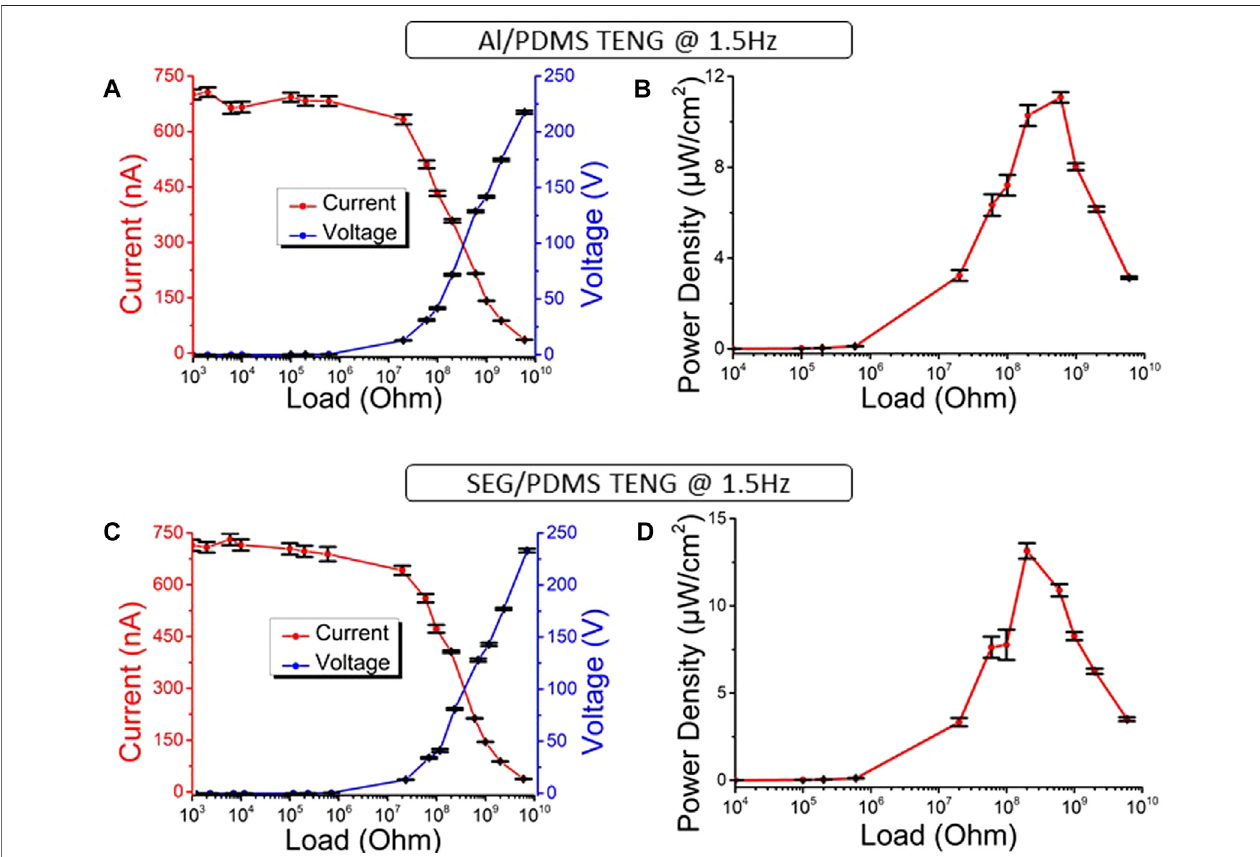
FIGURE 5 | Device output performances for several external loads, depicting voltage/current behavior and calculated power density for Al/PDMS (A,B) and SEG/ PDMS (C,D) .